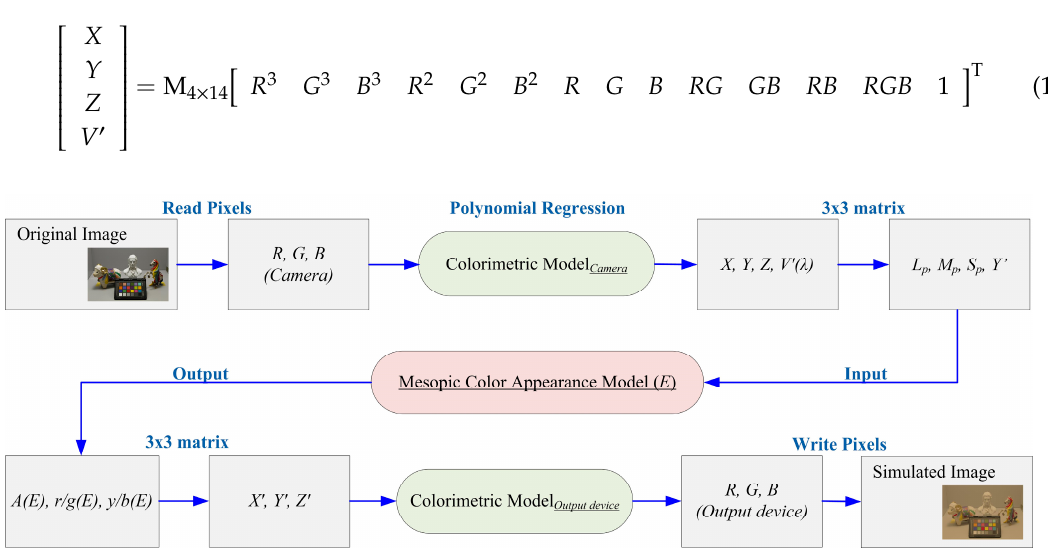
Figure 7. Flow chart of the mesopic color reproduction.